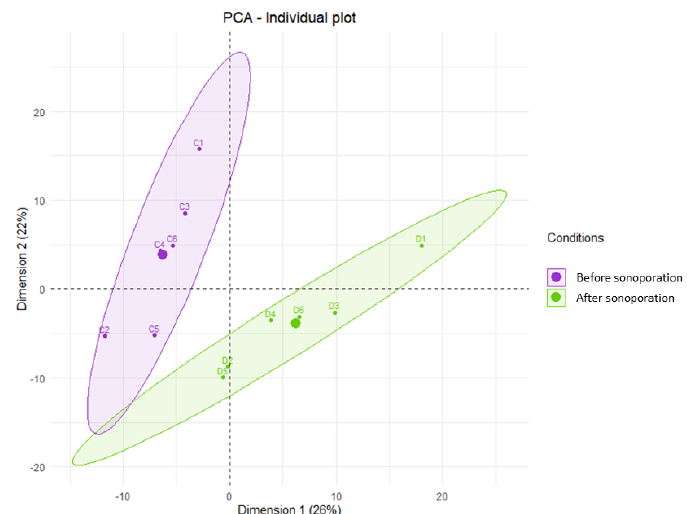
Figure 7. Unsupervised multivariate metabolomic analysis of plasma collected before and after sonoporation. The plot score of the PCA was constructed from the metabolites found according to components p1 and p2. Pre-sonoporation samples are shown in purple (C1 to C6) and post-sonoporation samples are shown in green (D1 to D6). Each group is associated with an ellipse grouping all its samples. The thicker dots correspond to the center of each ellipse.